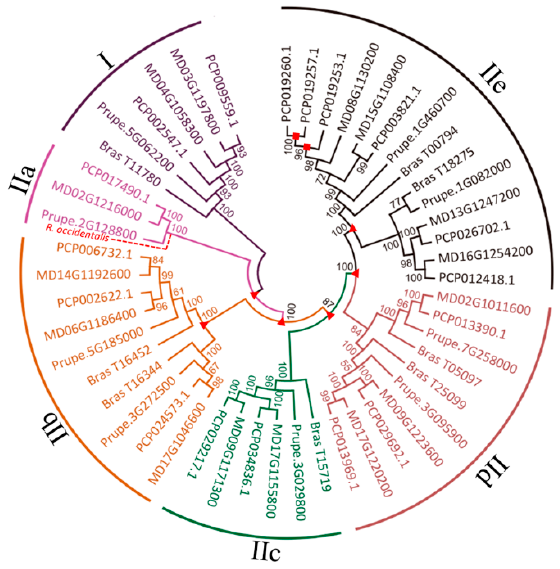
Figure 2. Phylogenetic tree derived from amino acid sequences of P 3A -Type ATPase genes in Rosacease genomes based on NJ method. The red triangle and square represent recent and old duplication events. Gene loss is shown by the red dotted line. All the bootstrap values are higher than 50% and indicated near branched lines.